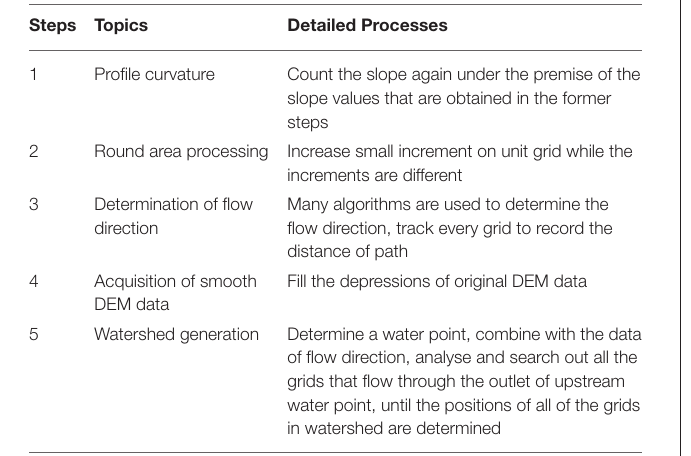
TABLE 2 | Detailed extraction processes.